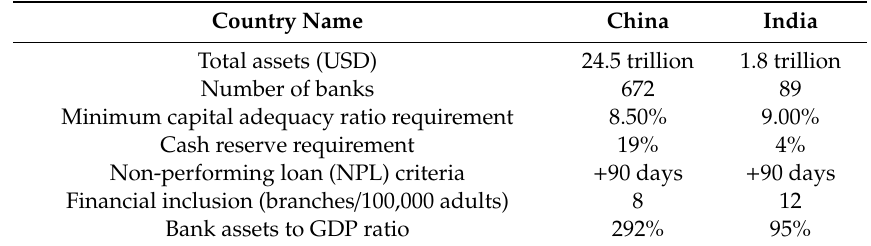
Table 2. Regulatory and institutional characteristics of banking systems in large emerging economies.